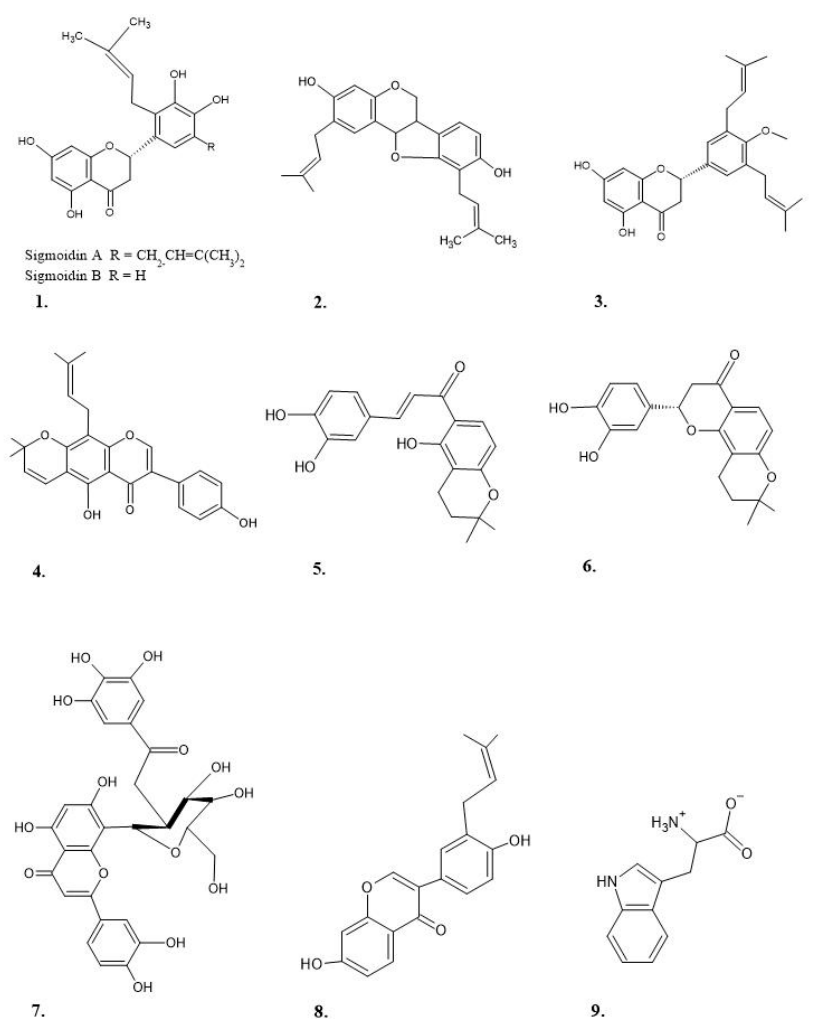
Figure 2. Main chemical structures are involved in the inhibition of the inflammatory process. Sigmoidin A and B ( 1 ), Erycristagallin ( 2 ), Abyssinone V-4 ′ -methyl ether ( 3 ), Waragalone ( 4 ), Mildbenone ( 5 ), Mildbone ( 6 ), 2 ″ -O-galloyl orientin ( 7 ), Neobavaisoflavone ( 8 ) and Hypaphorine ( 9 ). The chemical structures were created with the ACD/ChemSketch Freeware program.